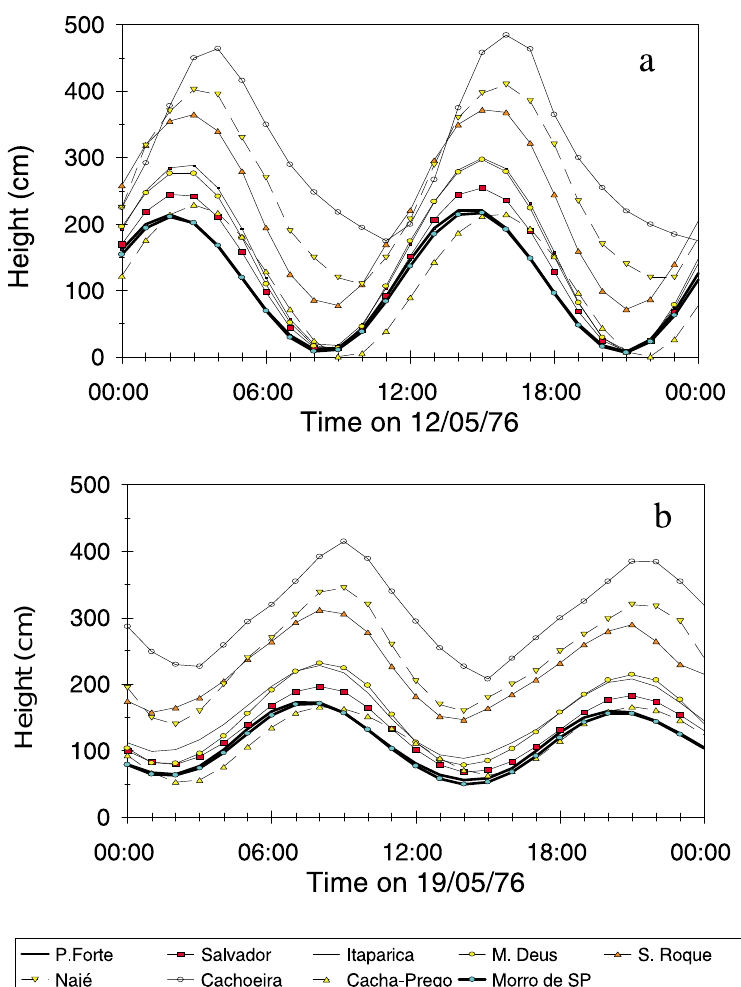
Fig. 4 – Simultaneous tidal cycles for 9 stations inside the TSB and the ocean station on the May 12th (spring tides – A) and May 19 (neap tides – B) 1976. The data belonging to São Roque, Najé and Cachoeira stations are field records, whereas the others are a result of tidal prediction. Low- and high-tide time lags between the ocean station and the innermost station (Cachoeira) are also